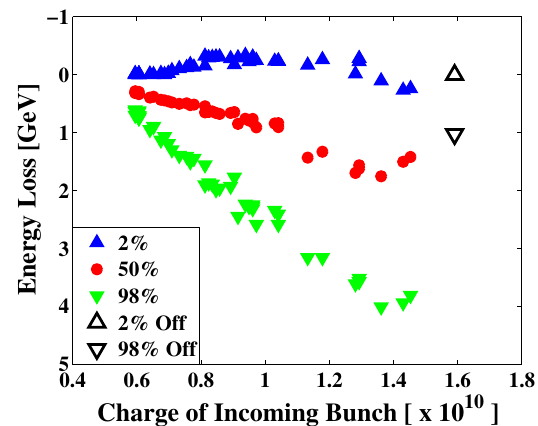
FIG. 5. (Color) ( Li (cid:1) (cid:1) N ) Distribution of the 2%, 50%, and 98% charge levels as a function of the incoming bunch charge. The 4 and 5 represent the 2% and 98% charge levels of the beam with no plasma.